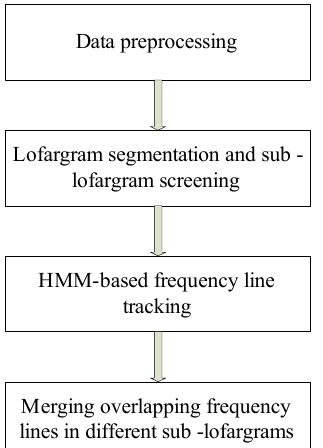
Figure 2. Improved multiple frequency line tracking algorithm based on hidden Markov model (HMM).